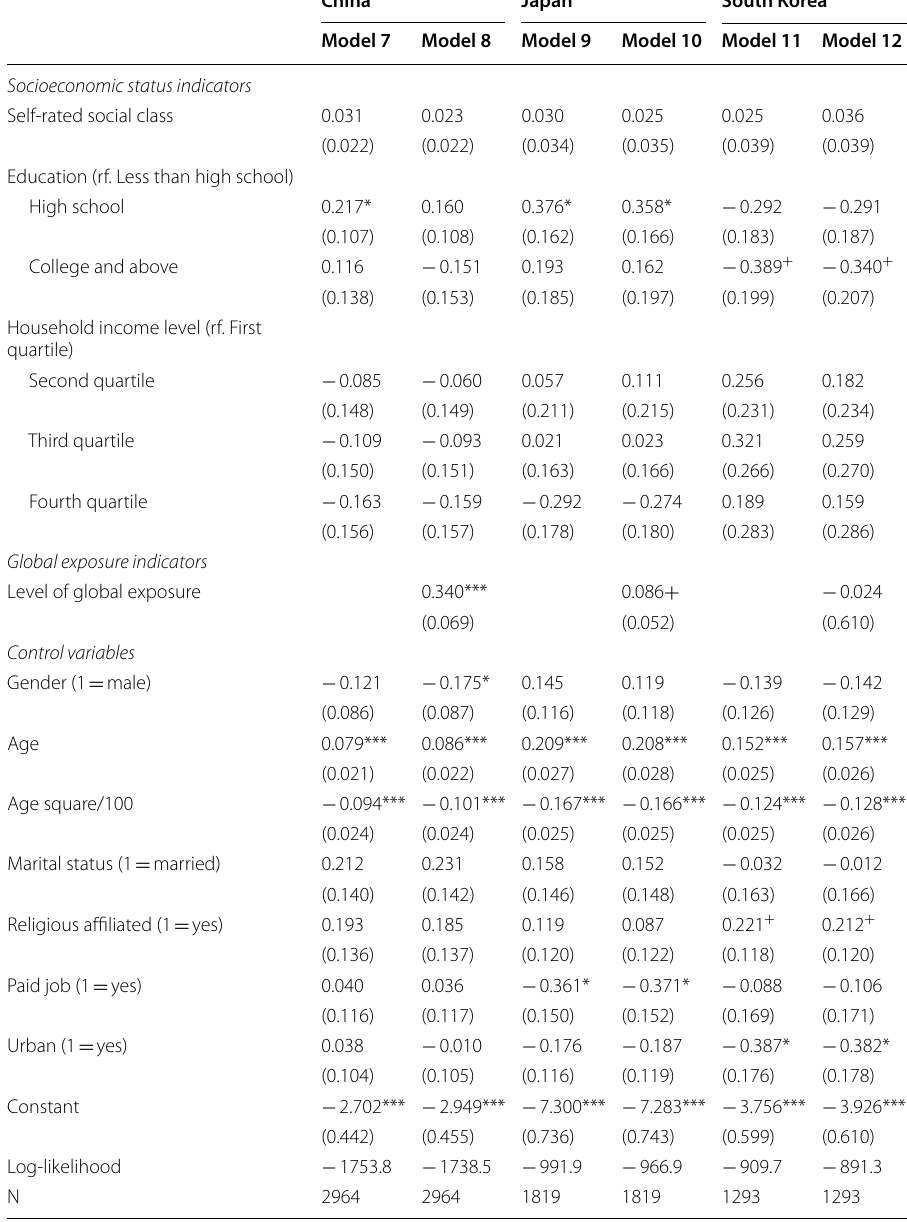
Standard errors in